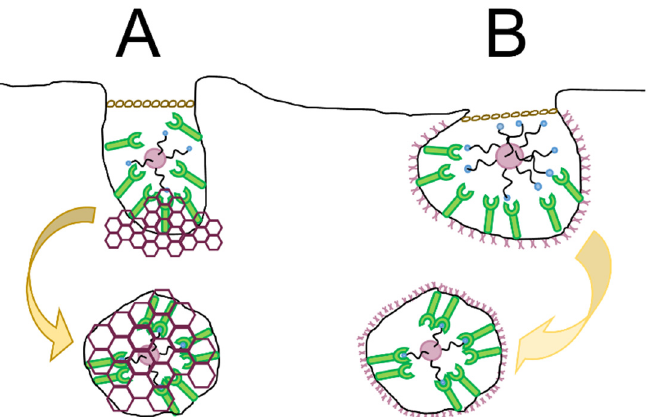
Figure 9. ( A ) A spherical-shaped nanoparticle with a low-density ligand pattern most likely to encounter clathrin pit for endocytosis. The clathrin-coated pit is deeply invaginated and pinched off from the plasma membrane to form a clathrin-coated vesicle following endocytosis. ( B ) A spherical-shaped nanoparticle with a high-density ligand pattern most likely enters the cell through caveolae-mediated endocytosis. The caveolae, a flask-shaped vesicle at the plasma membrane, is internalized and fused to form caveosomes. Adapted with permission from reference [326].